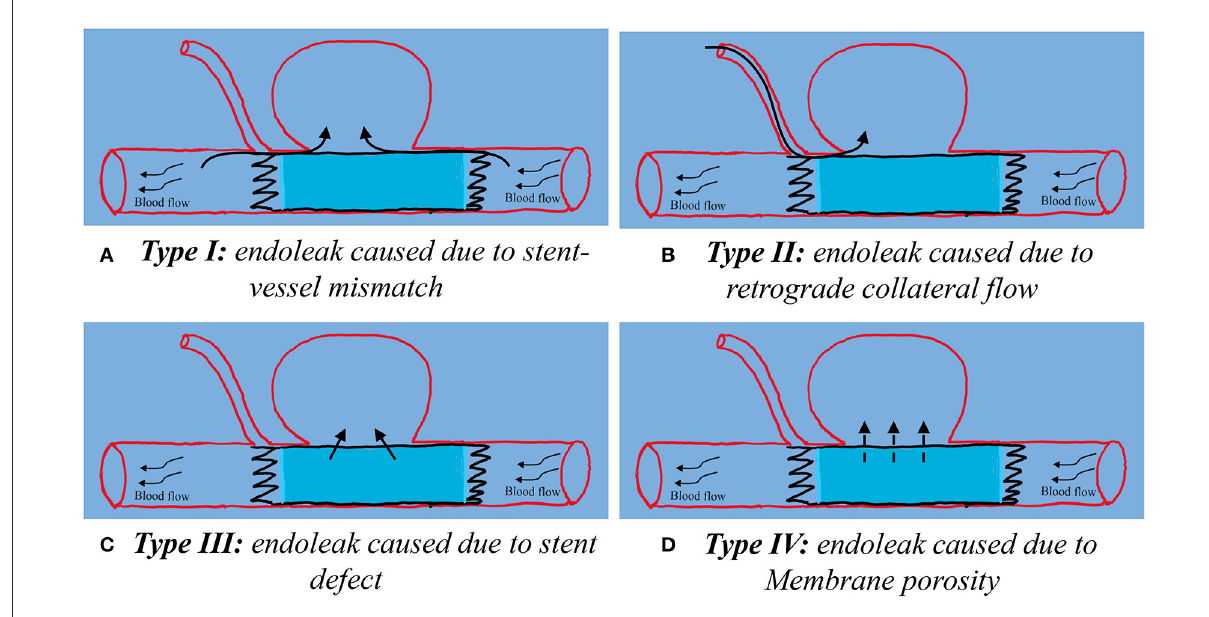
FIGURE3 Classification of the covered stent-associated endoleaks (20).